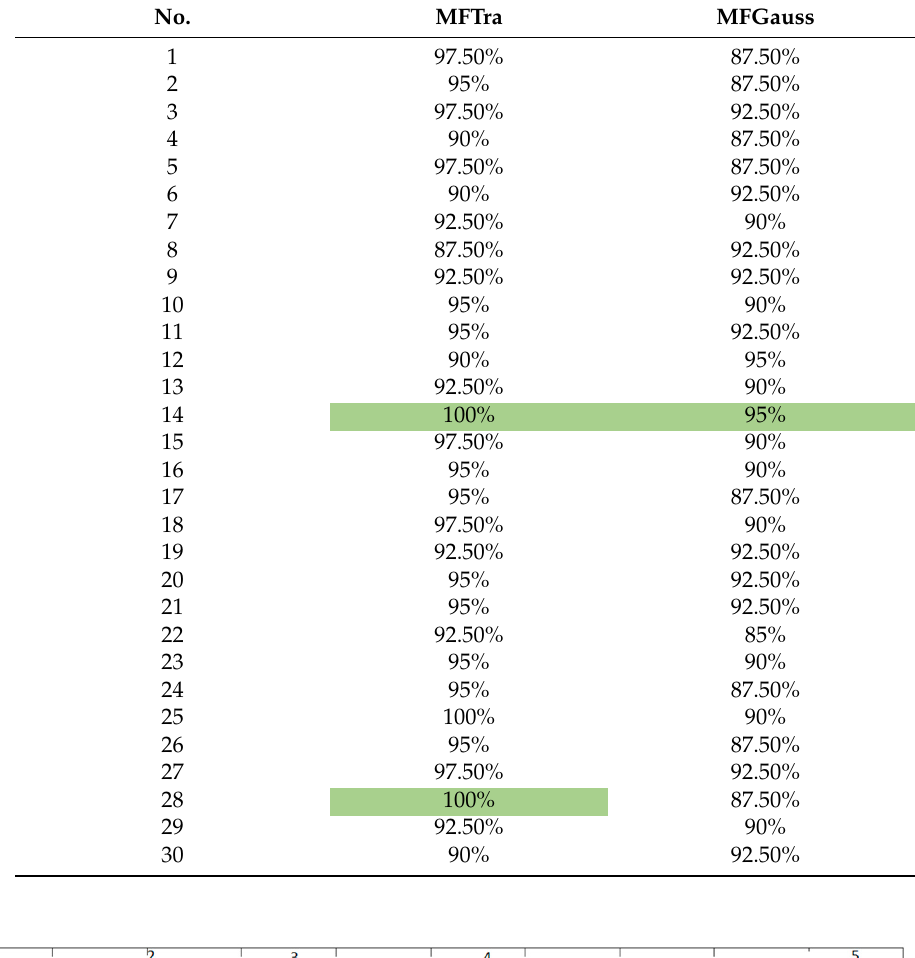
Table 4. Percentage of classification in each experiment with BSA.